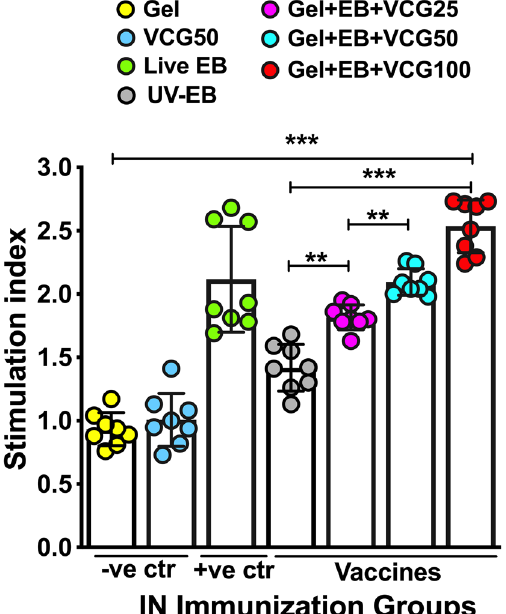
Figure 7. Proliferative responses of PBMCs from chickens immunized with UV-inactivated EB in combination with different doses of VCG. Groups of chickens (8/group) were immunized IN with two doses of the vaccine formulations and controls, 2 weeks apart. Three weeks after the booster immunization, PBMCs obtained by Lymphoprep density gradient centrifugation were restimulated in vitro with 10 6 IFU of UV-irradiated C. psittaci EBs ( C. psittaci antigen) for 24 h at 37 ℃ in 5% CO 2 . The antigen-specific proliferative response of PBMCs was determined using **the 5-Bromo-2’-deoxy-uridine (BrdU) cell proliferation assay kit (#K306; Abcam, Beijing, China); incorporation was detected by addition of TMB substrate and the optical density was read at 450 nm. Results are expressed as the stimulation index (SI), the ratio between absorbance values of stimulated and non-stimulated cells and the bars represent the mean and SD of three independent experiments. Significant differences between groups were evaluated by One-way ANOVA with Tukey’s post multiple comparison test at p *** < 0.001 and p ** < 0.01. Abbreviations: − ve ctr negative controls; + ve ctr positive